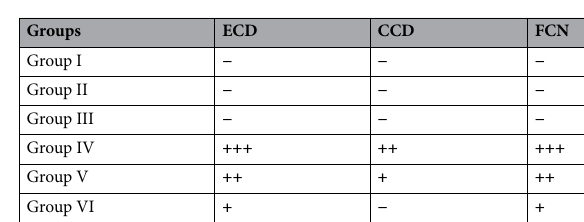
Table 3. Protective role of sage against meristematic cell damages induced by uranyl acetate. *Group I: Control, Group II: 190 mg/L sage, Group III: 380 mg/L sage, Group IV: 0.1 mg/mL uranyl acetate,